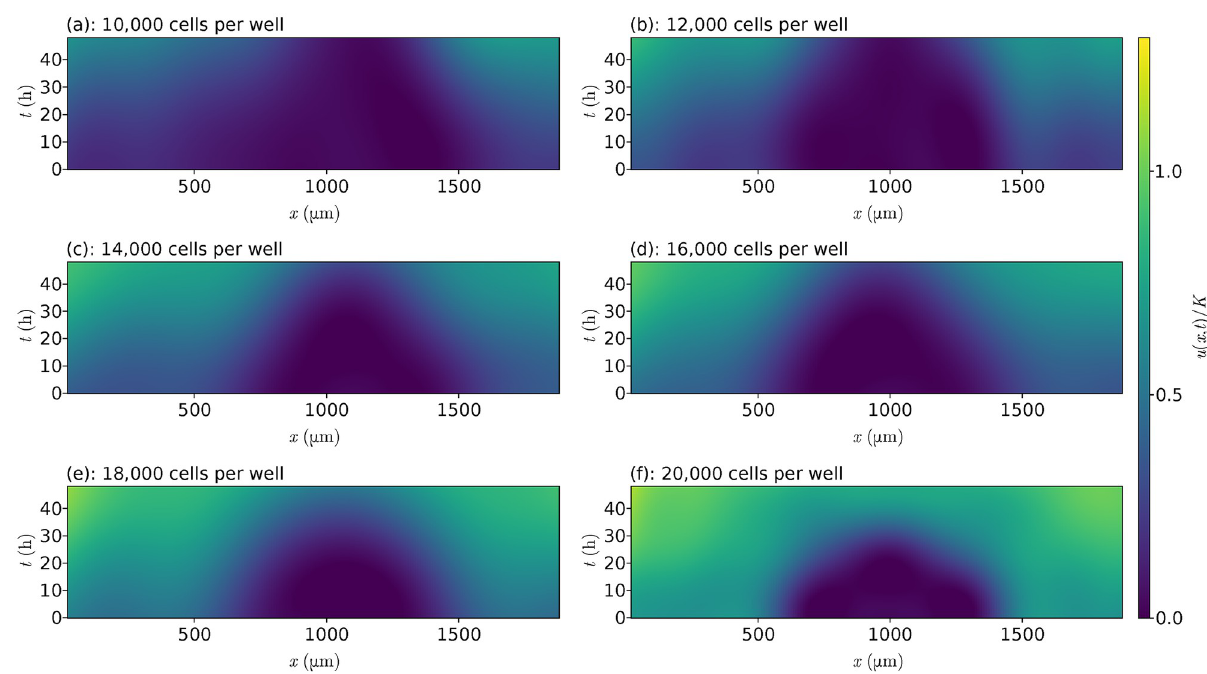
Fig 5. Space-time diagrams. Space-time diagrams from the fitted Gaussian processes to the data from Jin et al. [13] for each initial cell density, coloured according to u / K where K = 1.7 × 10 − 3 cells μ m − 2 .